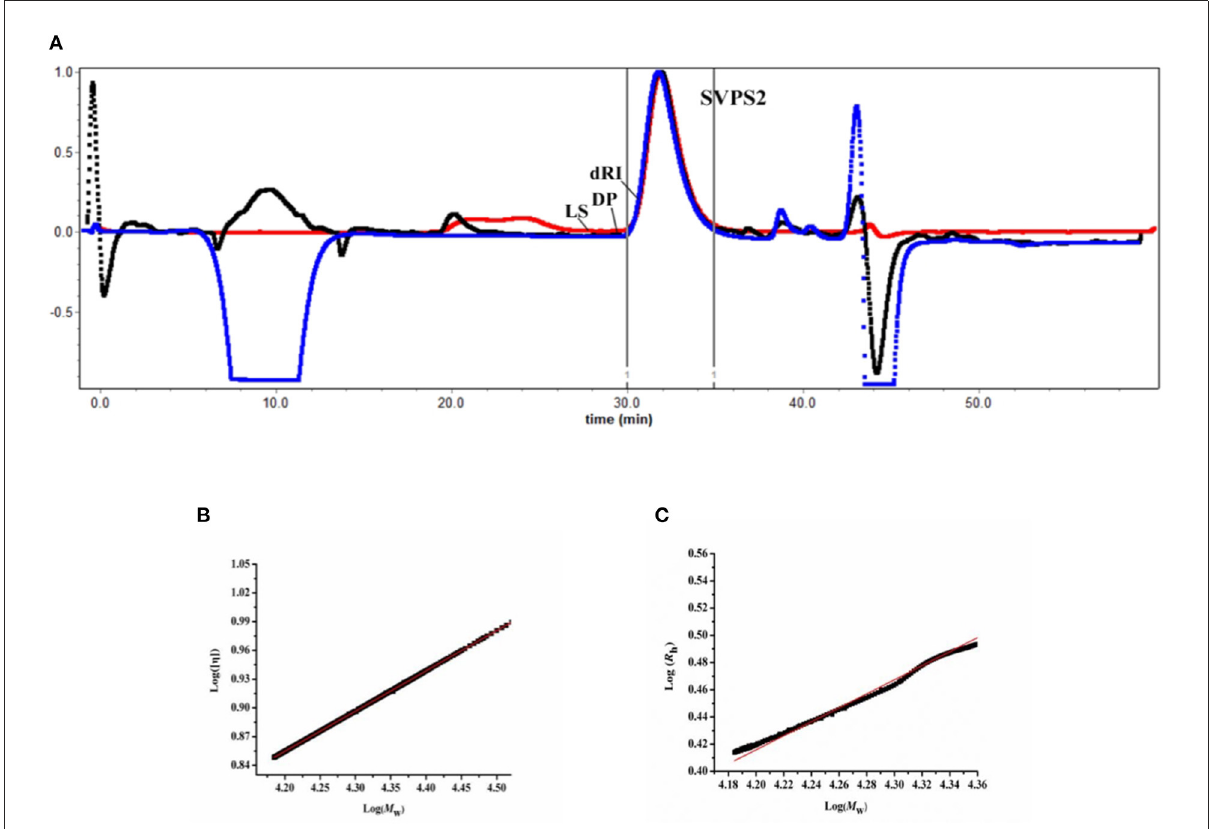
FIGURE4 Size exclusion chromatography profile of SVPS2 (A) , Double logarithmic plot of intrinsic viscosity ( η ) vs. molecular weight ( M w) (B) and hydrodynamic radius vs. molecular weight (C) for SVPS2.